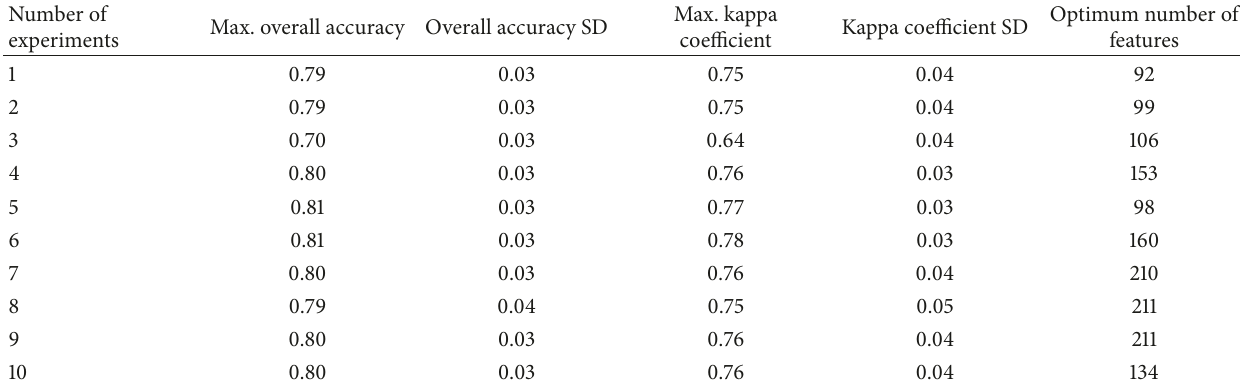
Table 4: Cross-validation results (size of ground truth data sets for each class = 300). The Standard Deviations (SD) across the 10-fold cross- validation in the case of optimum number of features are also